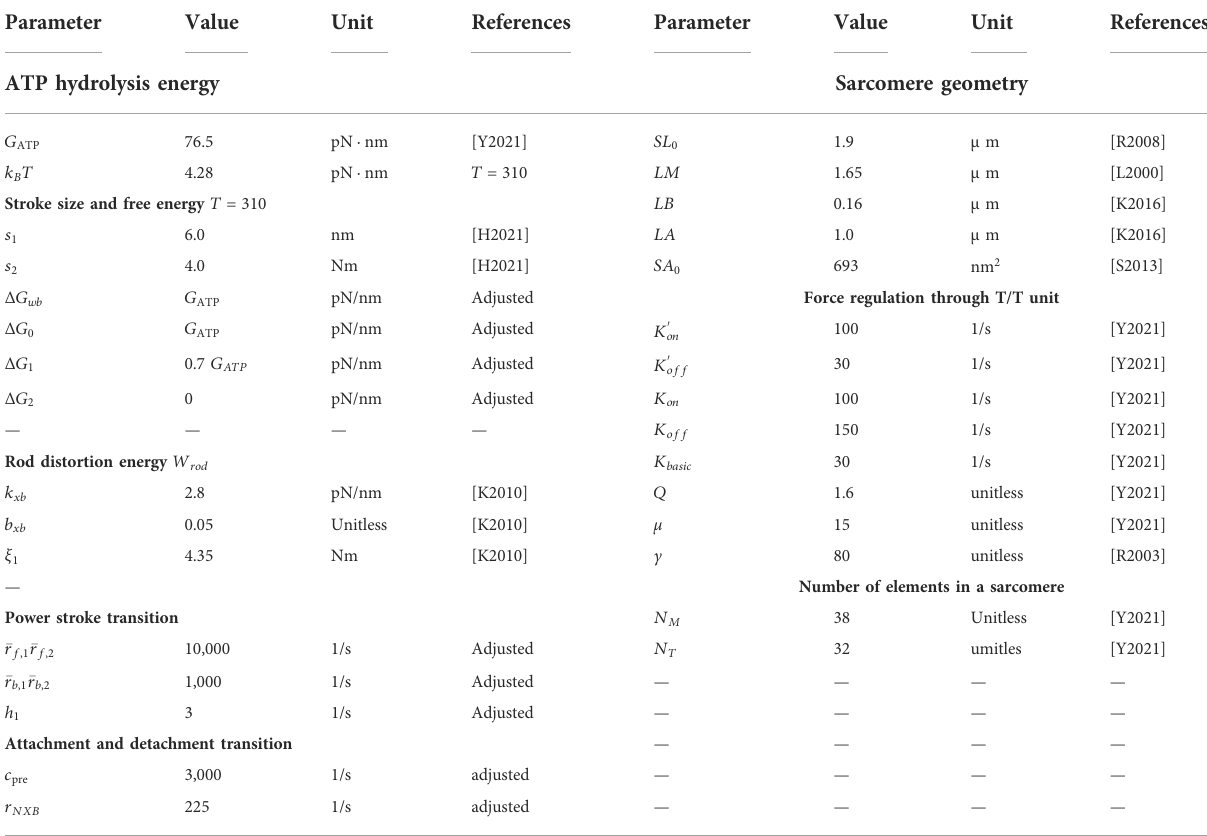
TABLE 1 Parameters for the actomyosin dynamics. “ Adjusted ” indicates that they were adjusted to reproduce the phenomena.